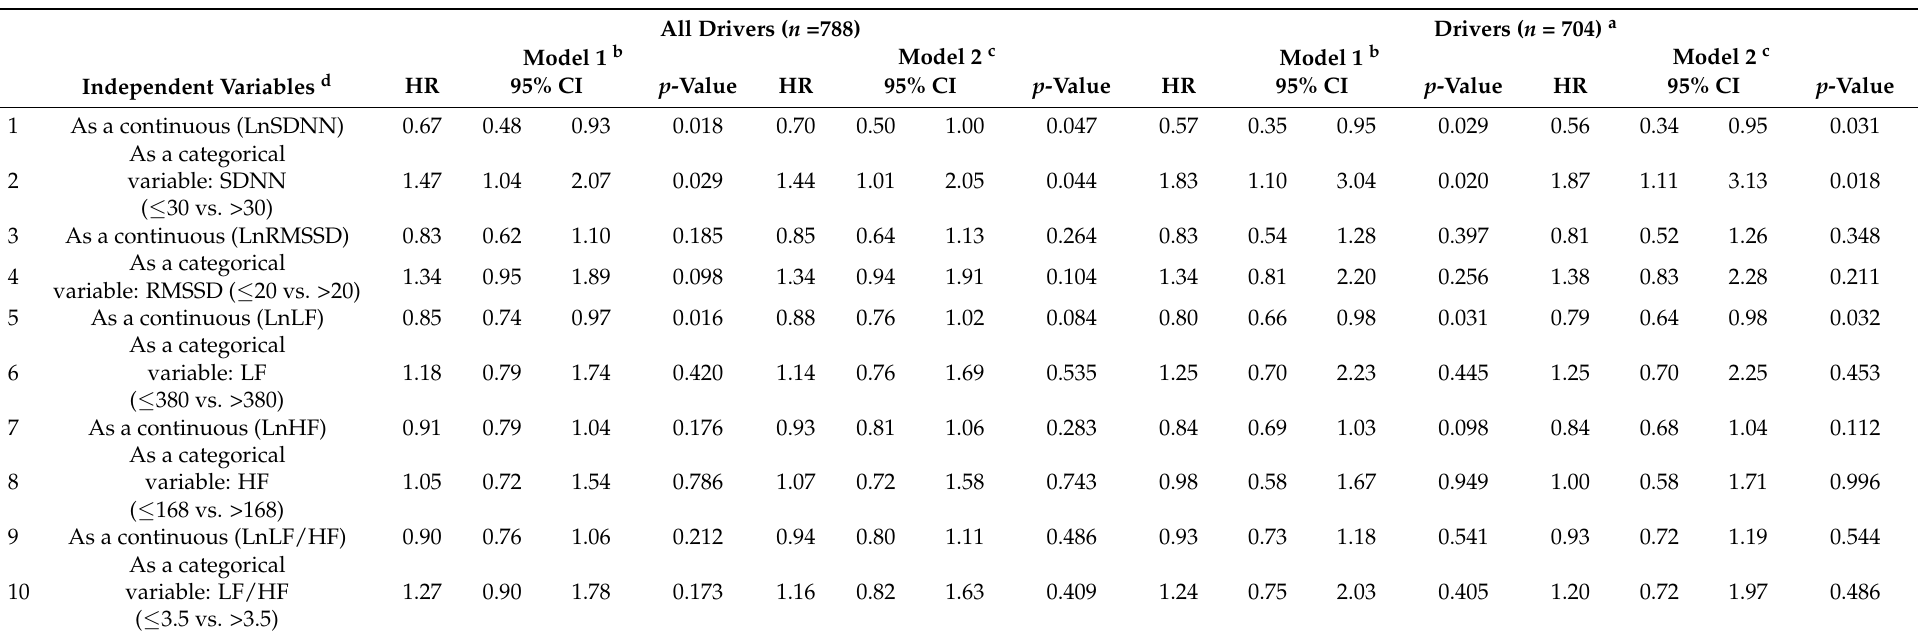
Table 2. Hazard ratios and 95% confidence intervals for cardiovascular disease by HRV index in the study